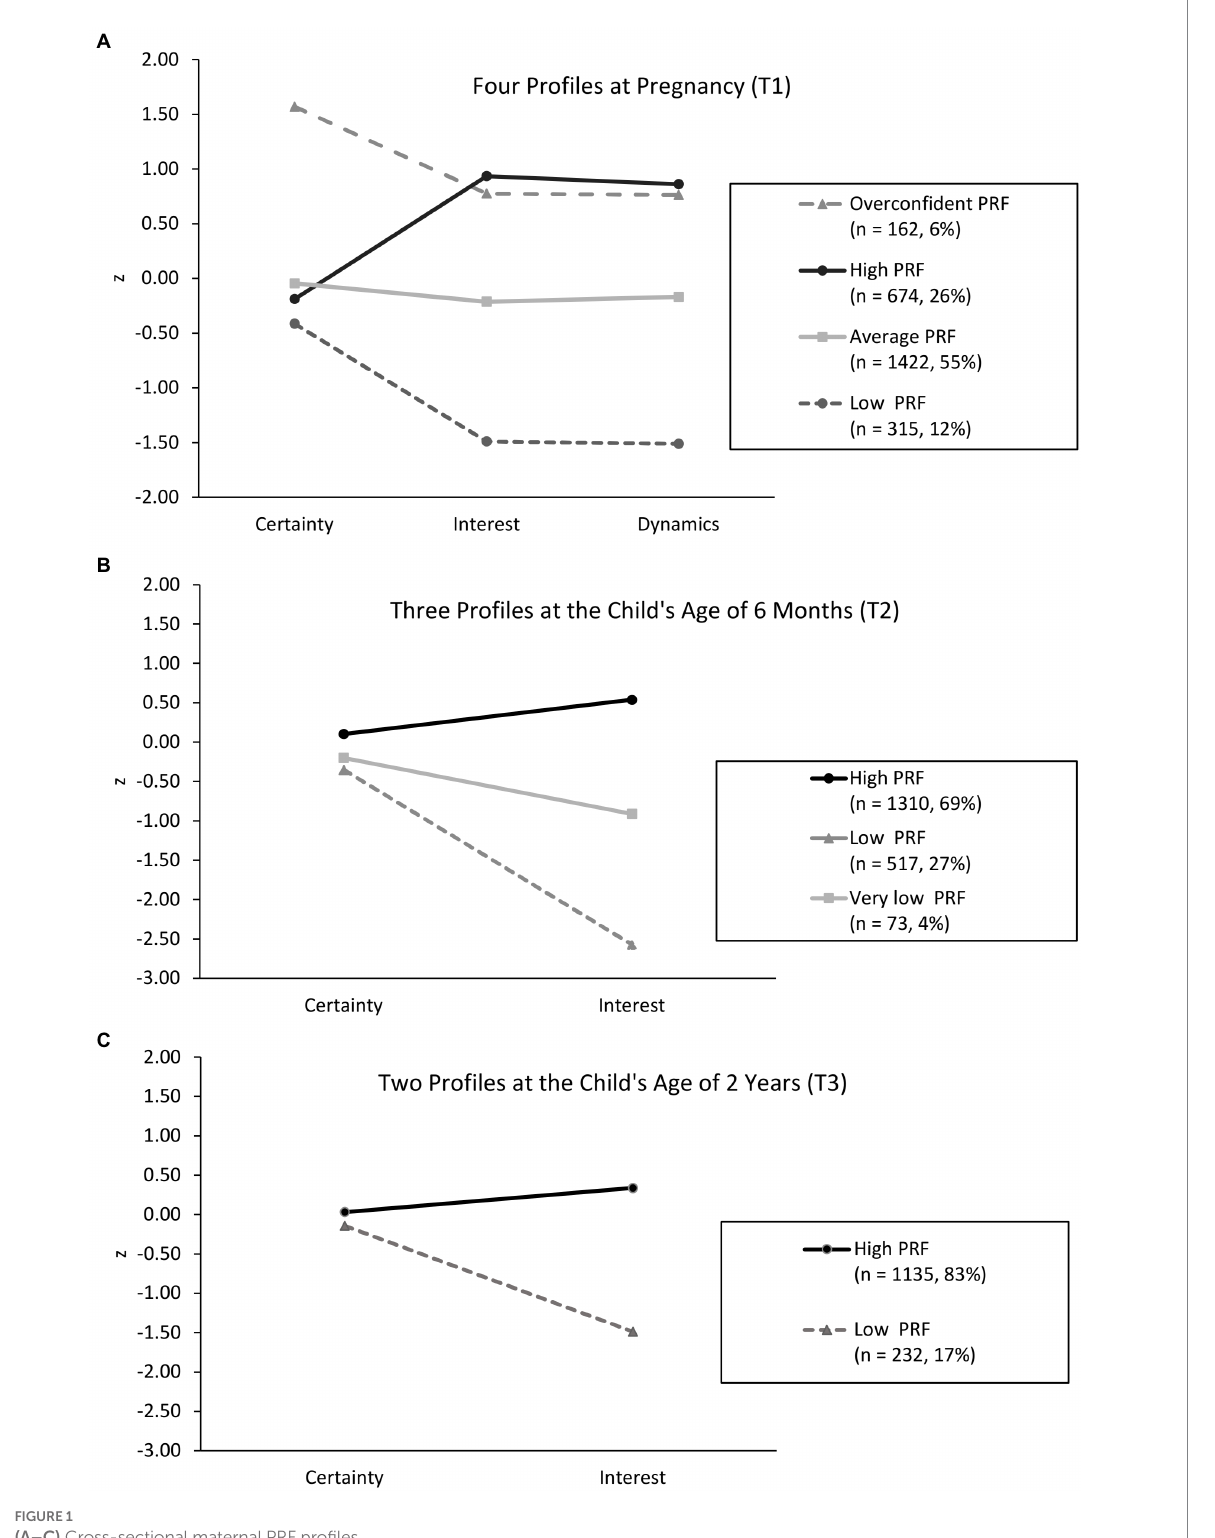
FIGURE 1 (A–C) Cross-sectional maternal PRF